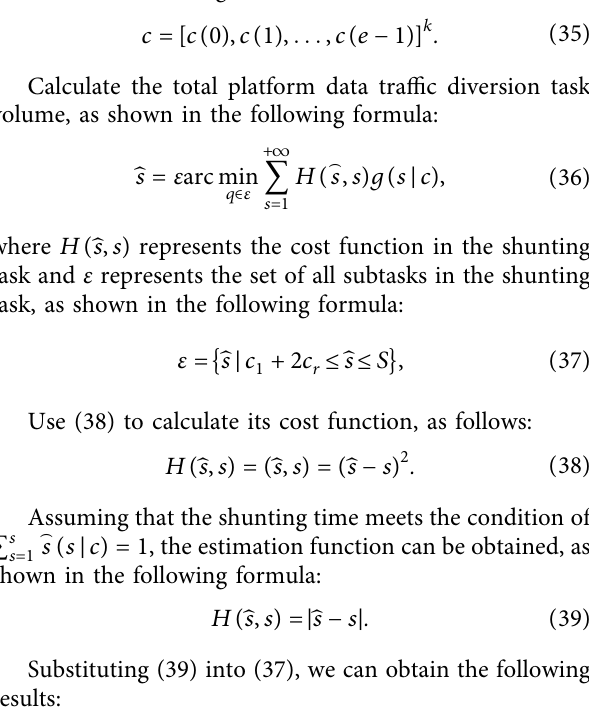
Figure 2: Comparison between equilibrium and social optimal � 10, λ � 3, and n � behavior ( μ 1 1